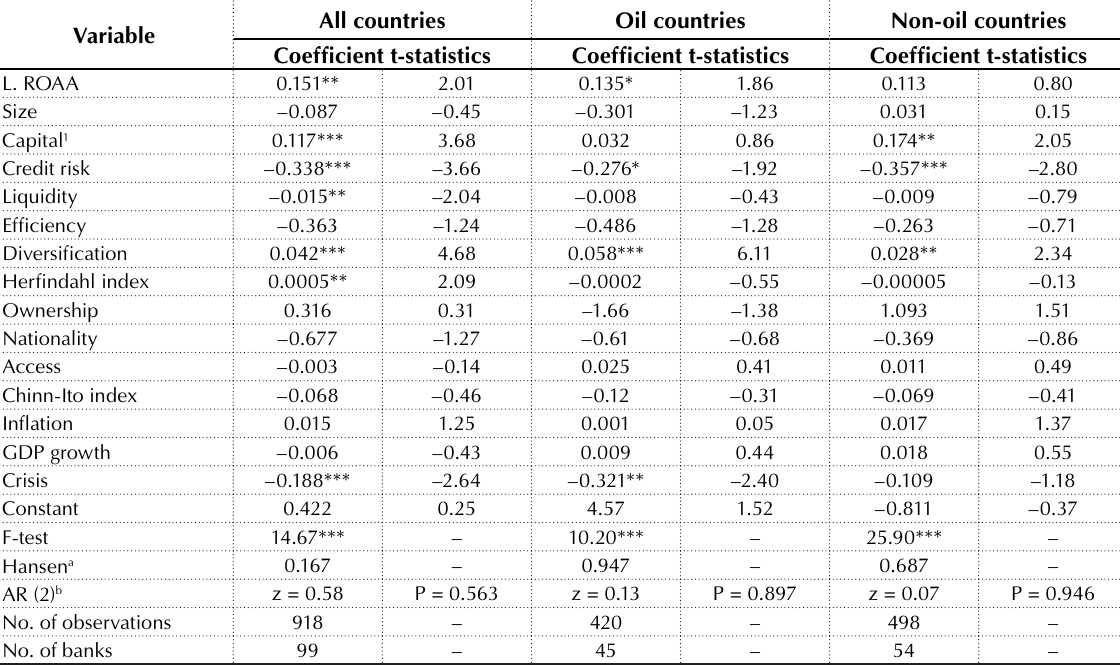
Table 4. GMM estimation results with ROAA as independent variable (regular reporting